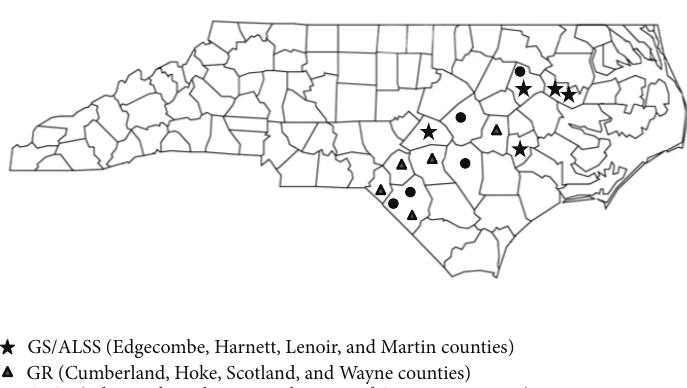
Figure 1: Locations of Palmer amaranth accessions collected during fall of 2005 used in the present study.